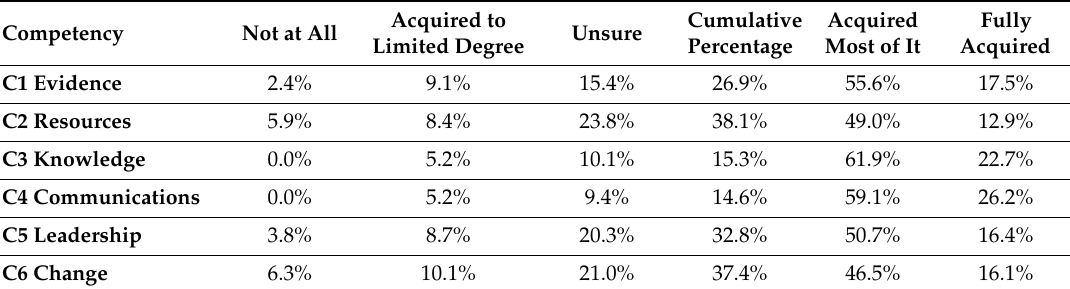
Proportions of managers acquiring competencies before taking up their current management